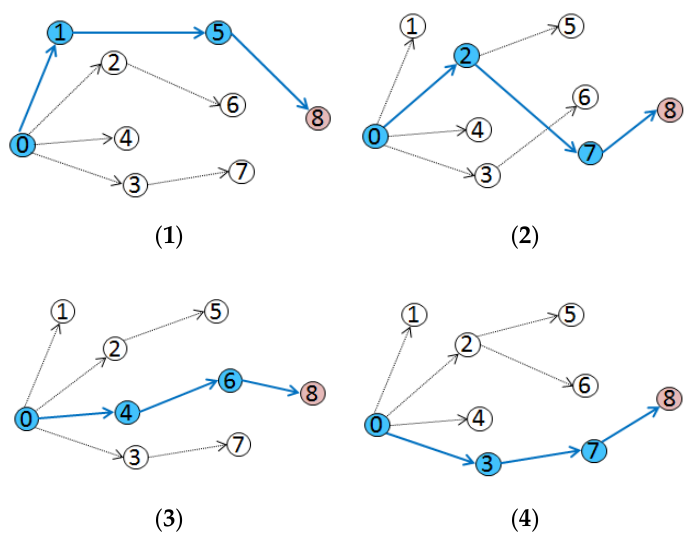
Figure 9 . ( 1–4 ) Comparison of routes in multi-hop experiments. Figure 9. ( 1–4 ) Comparison of routes in multi-hop